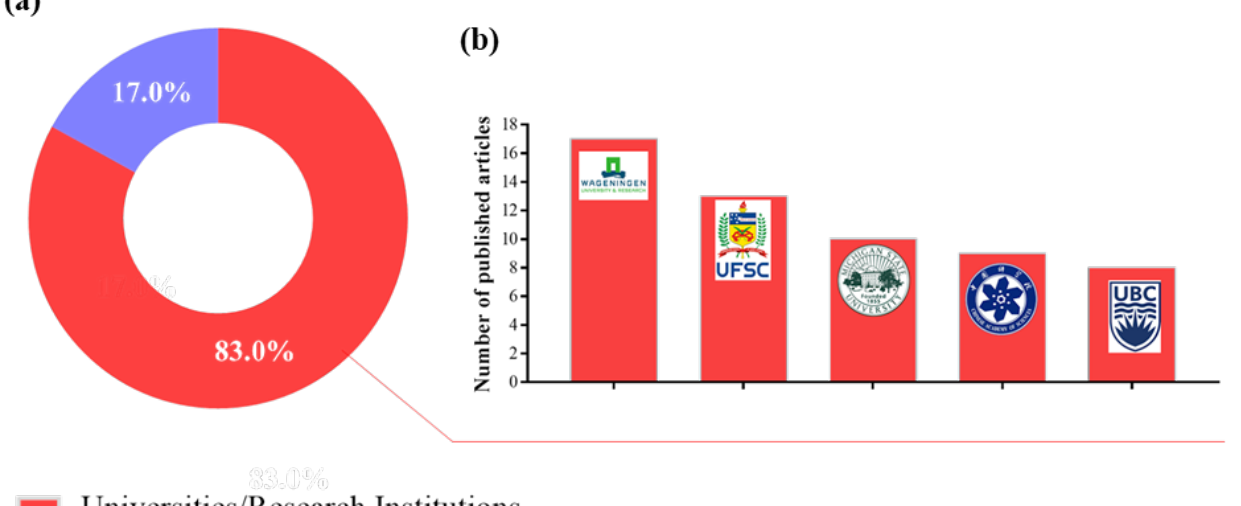
Figure 7. Distribution of the funders for articles published on the participation of family farming in the development of new food products ( a ) and the top 5 Universities/Research Institutions that provided the financial support for the published articles ( b ).